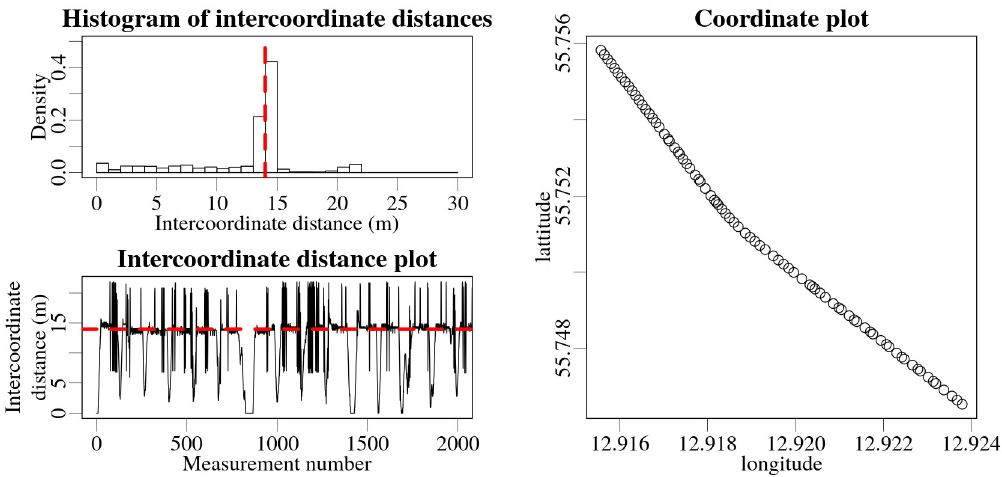
Fig 7. Intercoordinate distance analysis of the GNSS coordinates recorded and processed by the Nugget software for experimental set-up 1. The upper graph shows a histogram of the length of intercoordinate distances. The lower graph shows the intercoordinate distance values for each measurement. The average speed of the vehicle during the experiment was 50 km/ h (13.9 m/s), indicated by the red dashed